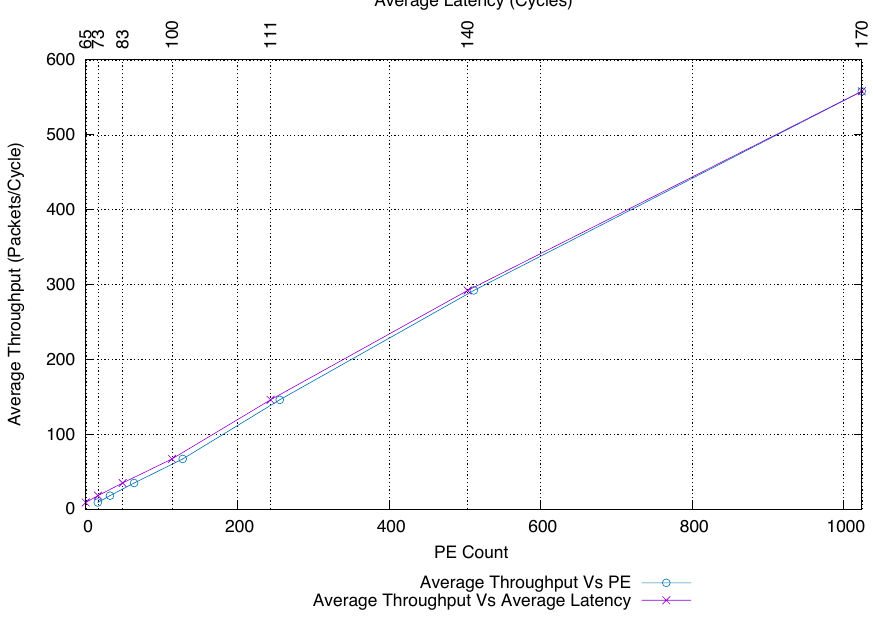
Figure 10. Comparing average network throughput and average packet latency with increasing network